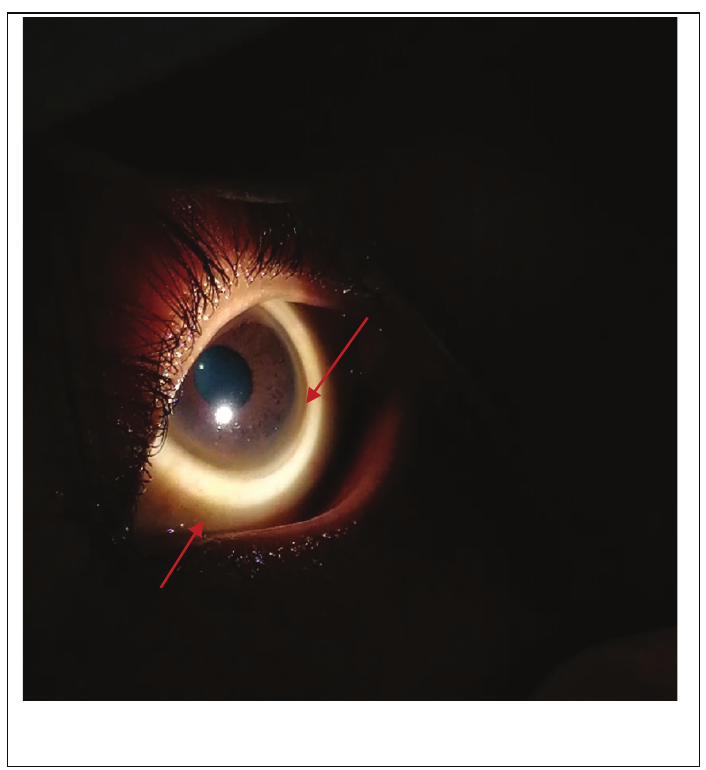
Figure 3 : A slit lamb examination showing Kayser–Fleischer ring (red arrow).